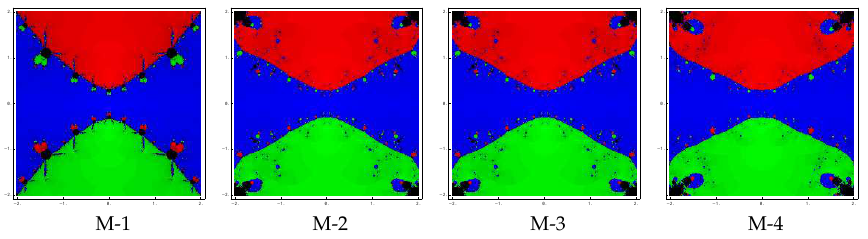
Figure 5. Basins of attraction by M-1–M-4 ( β = 10 − 4 ) for polynomial ψ 2 ( z ) .